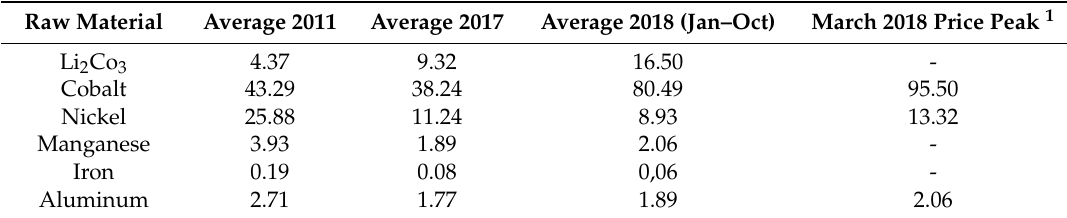
Figure 4. Comparison of cost breakdowns of NCA, NMC-111, NMC-442, and NMC-532 cathode active materials into raw material and processing costs between 2011 and 2017. Delta values indicate change in USD kg − 1 per cost fraction. 2011 data adapted from [22]. Table 2. Relevant raw material prices over time.